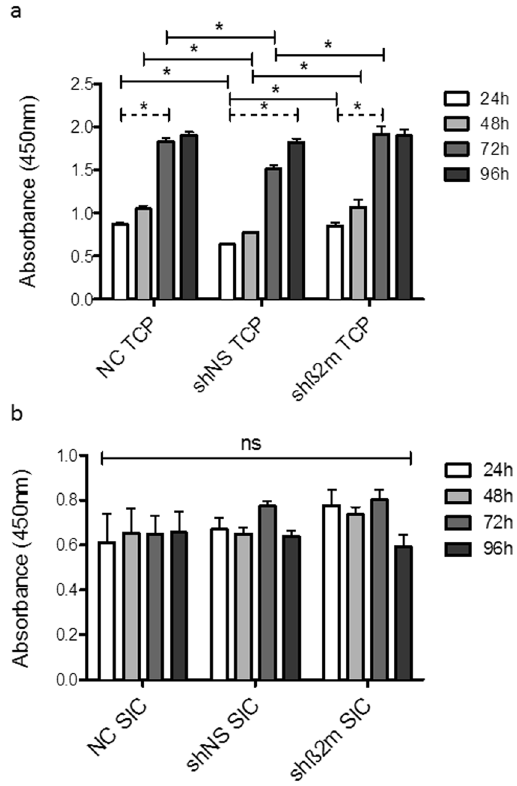
Figure 3. HLA class I silenced ECs are suitable for SIC endothelialization. ( a ) For each cell type on TCP, WST-8 assays results confirm a daily significant increase of the absorbance up to 72 h, until a steady state is reached on day four. ( b ) The seeding protocol of SICs resulted in a steady state of the absorbance from the outset without any significant differences between the cell types, indicating a stable and viable endothelial monolayer on